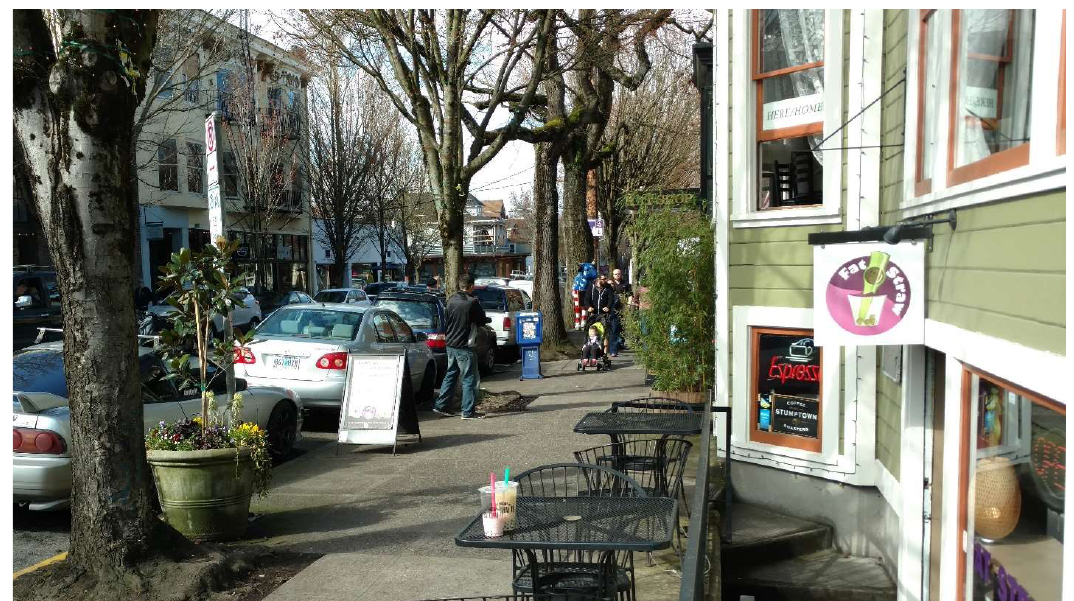
Figure 6. A walkable streetscape in the fashionable Northwest District, Portland, OR, USA. Photo by